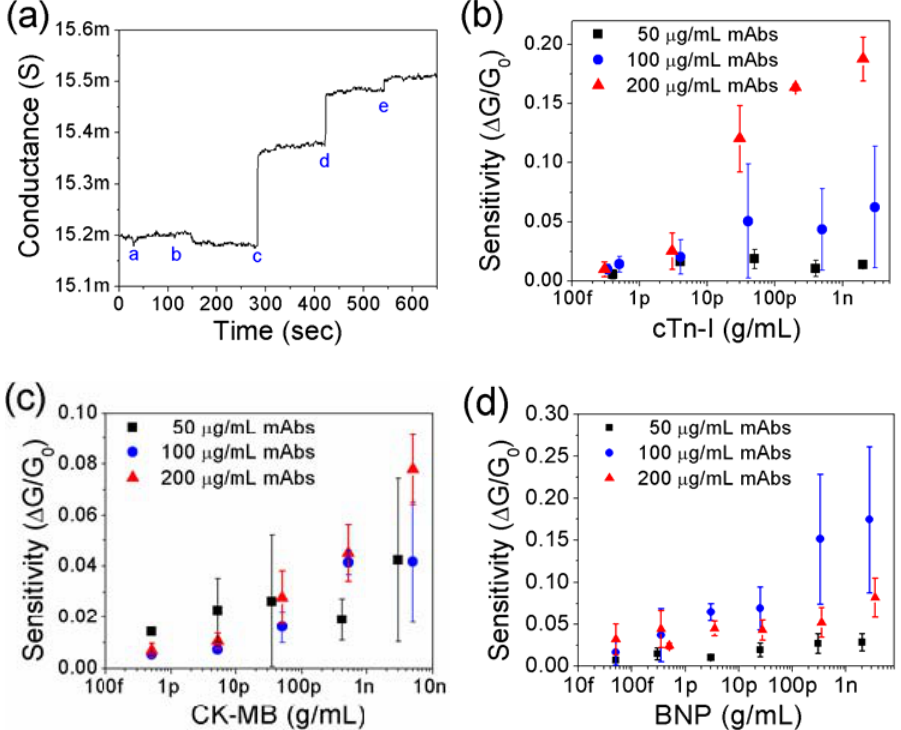
Figure 5. Biosensing of cardiac biomarkers in a broad sensing range and optimization of sensing performance. ( a ) Stepwise change of conductance according to introducing different concentrations of BNP to the nanowire biosensor (a: PBS, b: 100 ng/mL